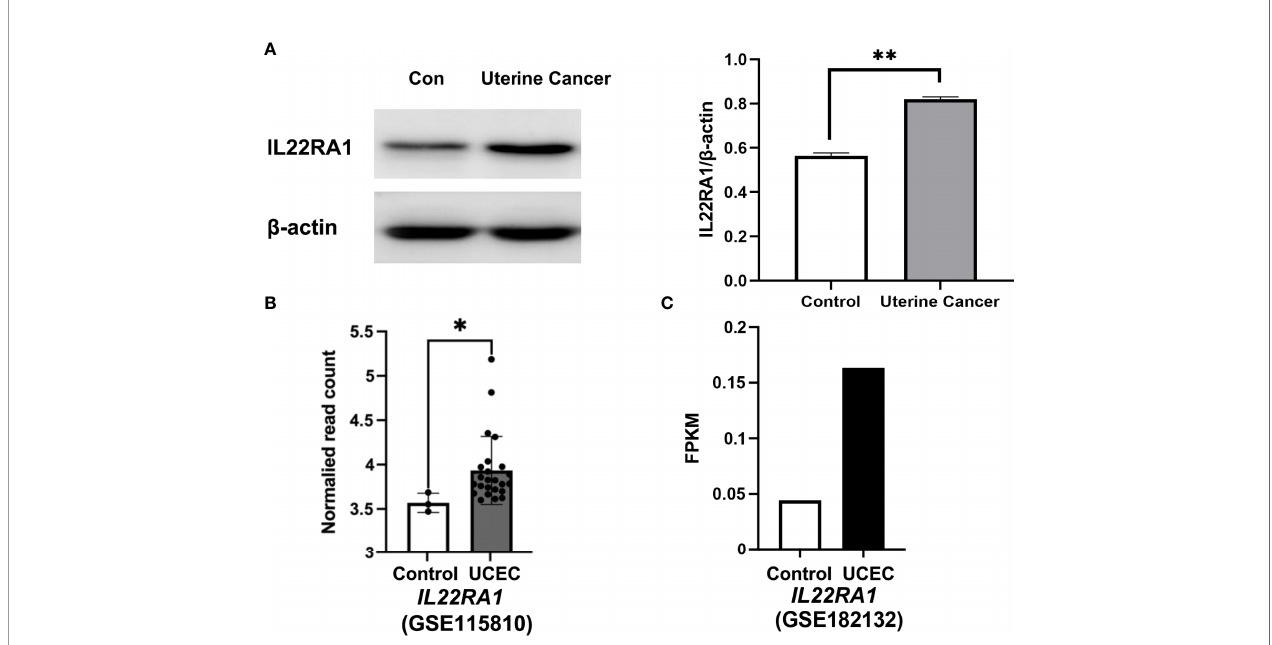
FIGURE 5 | IL22RA1 expression in uterine cancer at protein and transcript level. (A) Representative Western blot results for IL22RA1 in uterine cancers from dogs (left panel). Results are presented as the ratio of the IL22RA1 band intensity to the intensity of the b -actin band (n = 3, right panel). (B, C) RNA seq data showing the transcript level of IL22RA1 in UCEC tissues and normal control tissues using GSE115810 and GSE182132 cohorts from GEO database. * p < 0.05, ** p <